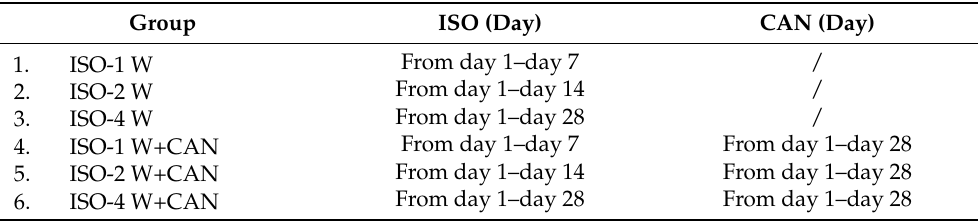
Table 1. Grouping and treatment in